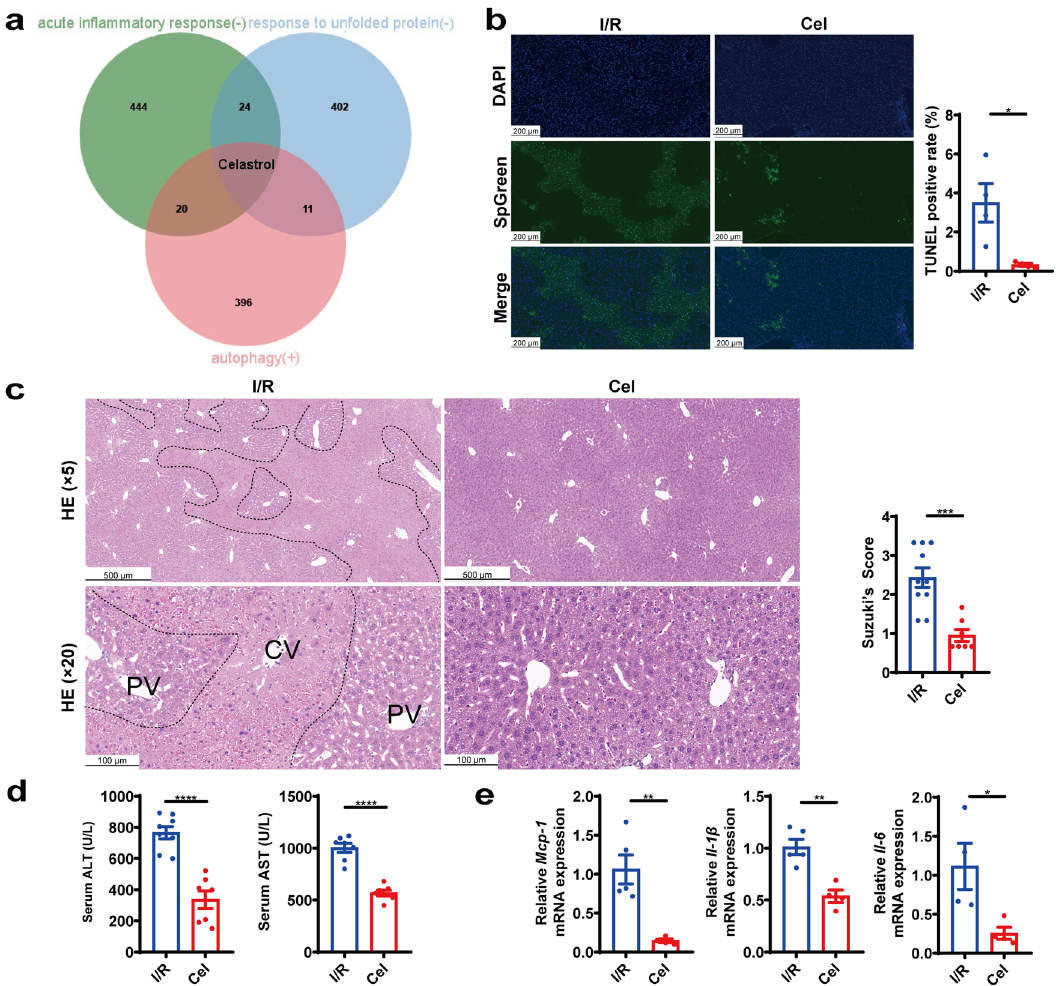
Fig. 5 Celastrol (Cel) reduced hepatic I/R injury in mice. a The intersection of CMap signatures from I/R regulated and zone 3-speci fi c DEGs involved in UPR, acute in fl ammatory response and autophagy pathways. b , c Representative TUNEL staining and TUNEL positivity and representative H&E staining and histological score of I/R and celastrol group. d , e Serum ALT and AST levels and mRNA expression of hepatic Mcp-1 , Il-1 β , and Il-6 in I/R and celastrol group. Student ’ s t-test, n = 4 – 10, * p < 0.05, ** p < 0.01, *** p < 0.001, **** p < 0.0001. Data were expressed as mean ± SEM. The black dotted line indicates zone-dependent injury